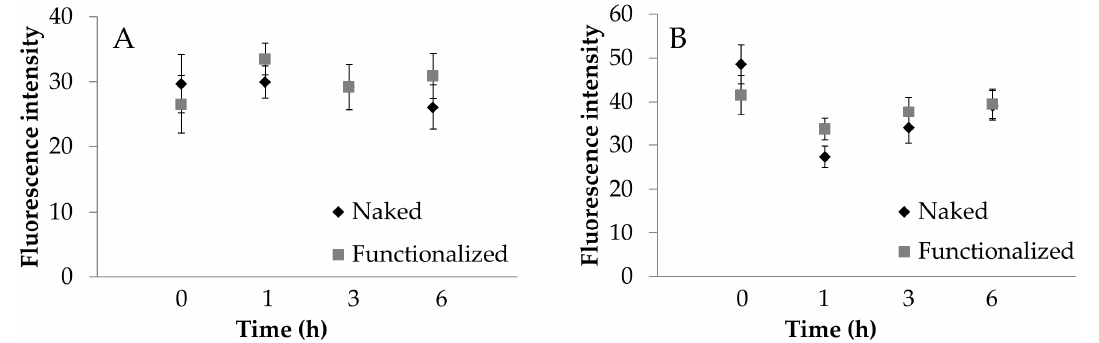
Figure 8. Cellular uptake of naked (black) and functionalized (grey) SFNs by Caco-2 ( A ) and ECV ( B ) cells after incubation for 1, 3 and 6 h at 0.01 mg/mL. Fluorescence intensity was extracted from the images collected by a Zeiss Axioskop 40 microscope. Data are reported as mean values and least significant difference (LSD) intervals, ANOVA. The overlap of two LSD intervals graphically indicates the absence of significant differences ( p > 0.05).